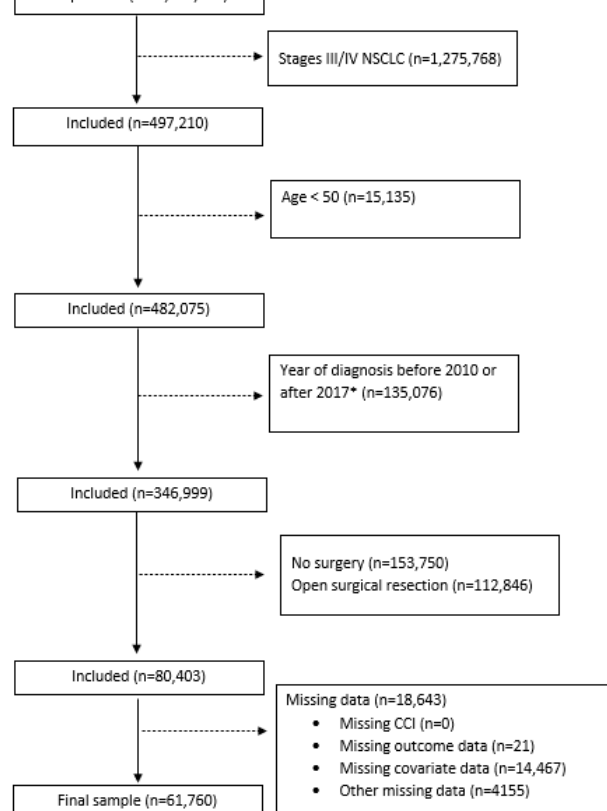
Figure 1. Flowchart for study participants selection. Abbreviations: NSCLC: non-small-cell lung cancer; CCI: Charlson comorbidity index. *Diagnosis years 2010–2017 selected due to inconsistencies in surgical resection classification for cases diagnosed prior to 2010 and lack of survival data for cases diagnosed in 2018.